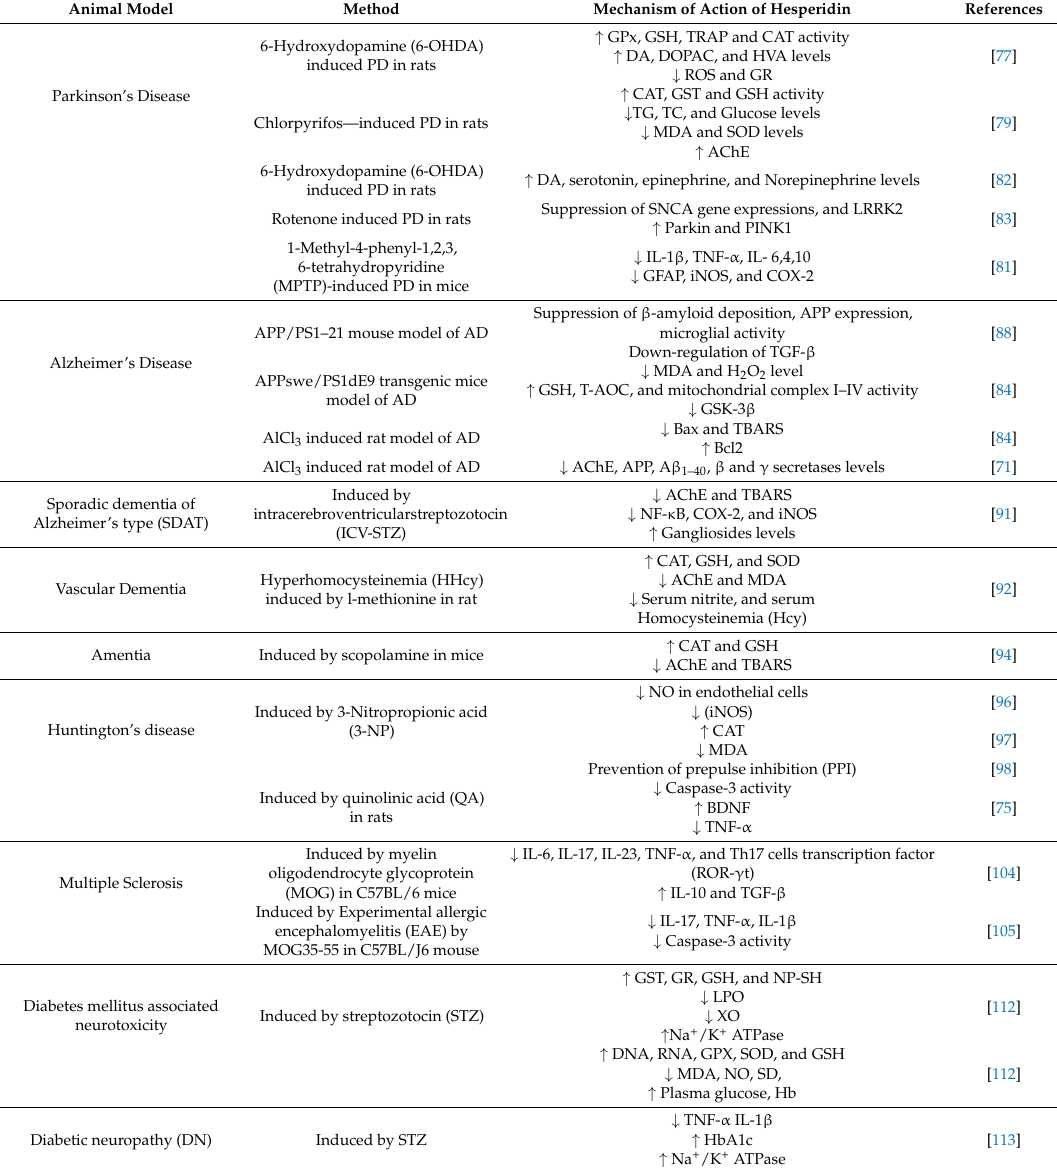
Table 1. In vivo studies demonstrating the neuroprotective effects of